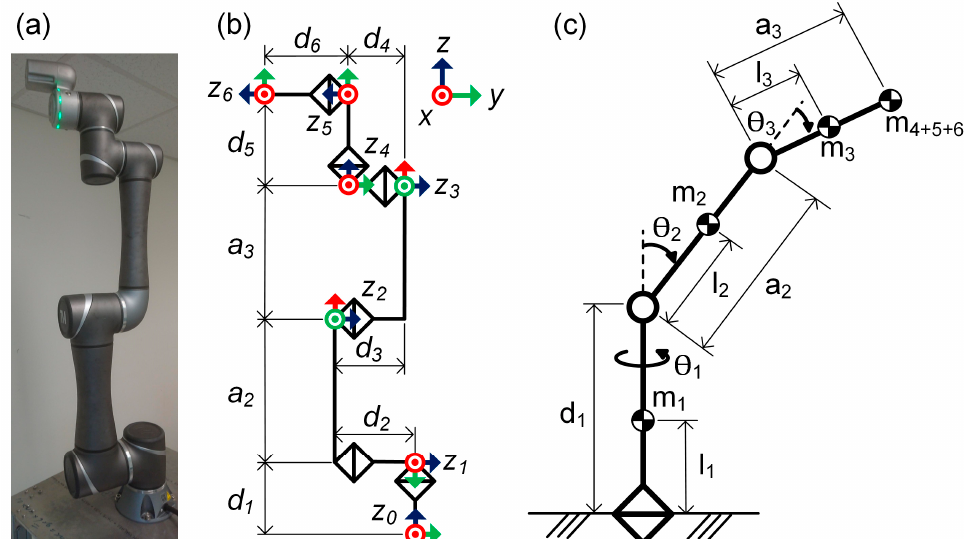
Figure 1. The manipulator and the model: ( a ) a photograph of the manipulator for experimental validation, ( b ) schematic diagram and coordinate systems of the manipulator, and ( c ) the three-DOF reduced-order model of the manipulator.